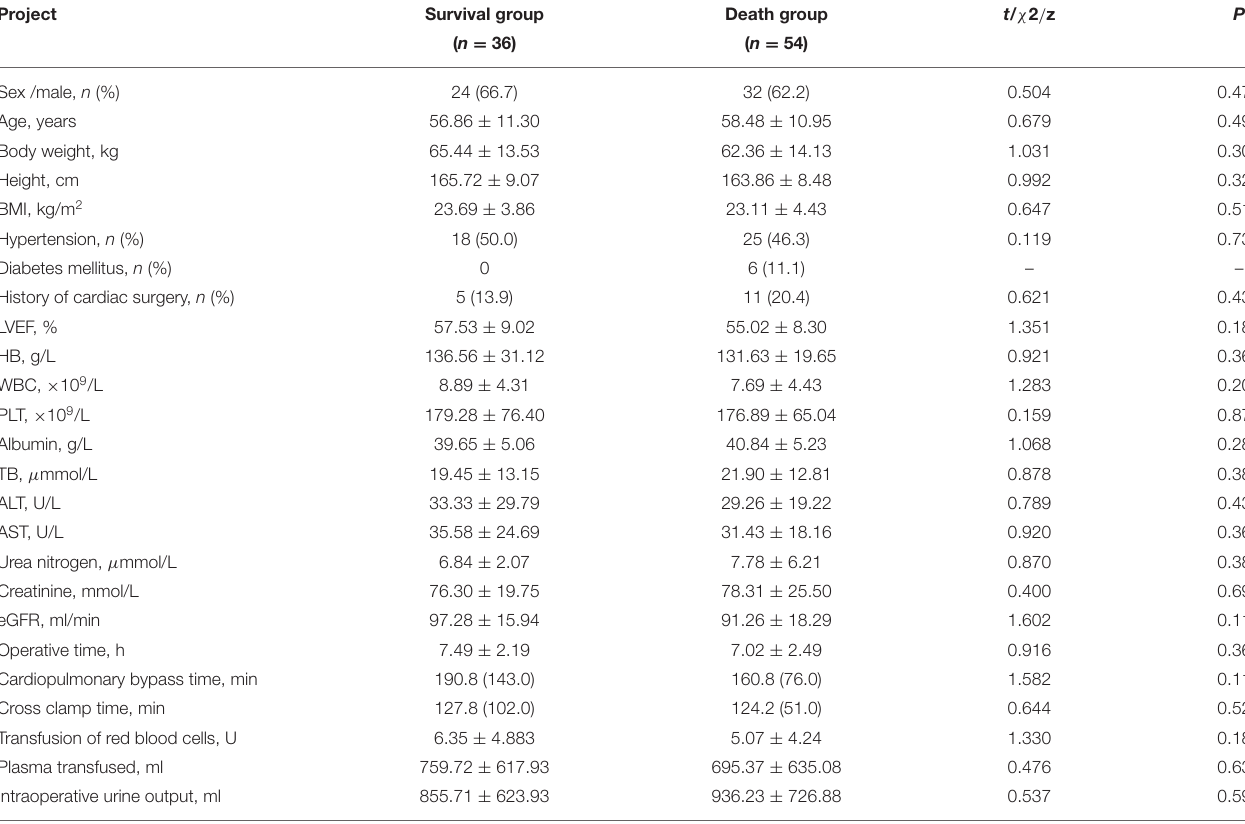
TABLE 1 | Univariable analysis of preoperative and intraoperative data.